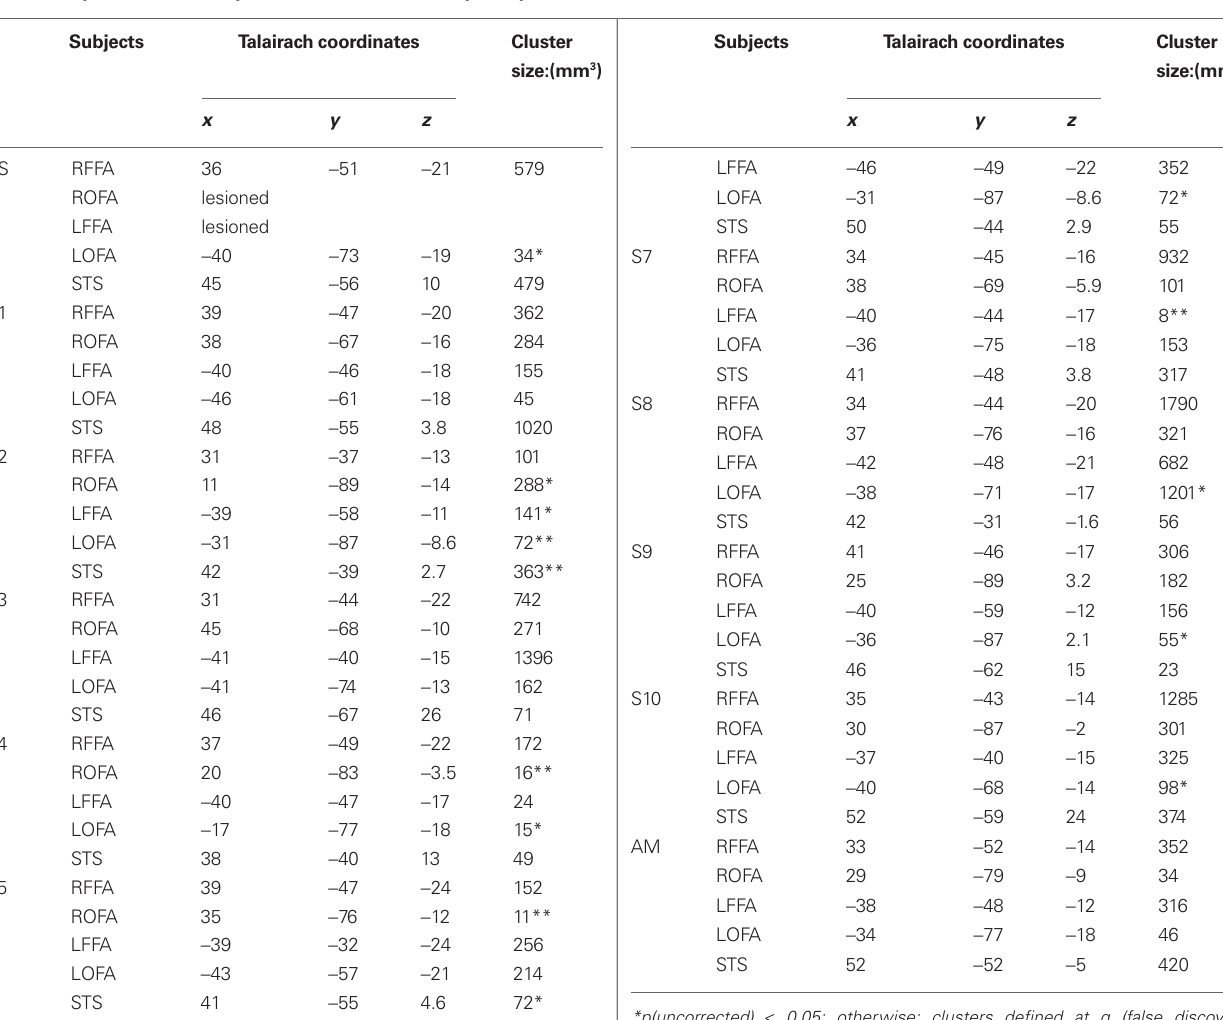
Table A1 | Talairach locations, and cluster sizes of the functionally defined regions of interests (right and left-sided FFA, OFA and right pSTS) in the localizer experiments for the patient PS and the control